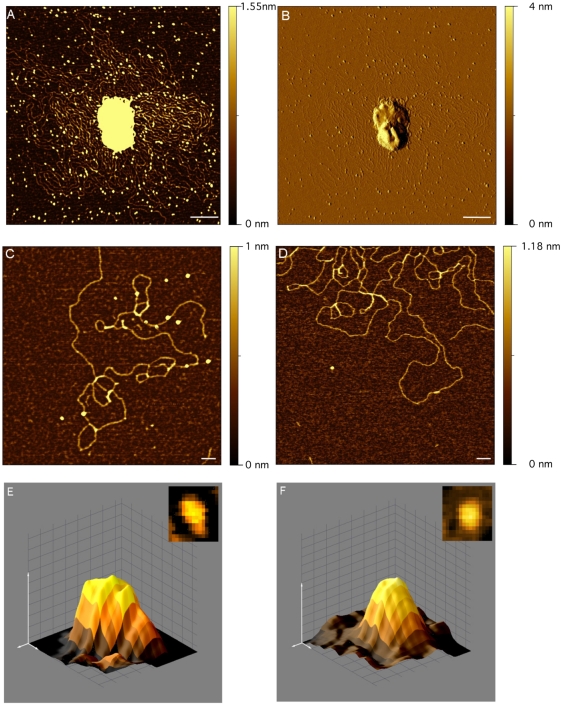
AFM images of viral DNA and associated proteins, which were isolated by osmotic shock.Scan of single PBCV-1 particles after osmotic shock in a height image A and in amplitude image B. The images reveal emerging DNA and protein particles from the disrupted virus. Magnification of DNA from disrupted virus with protein particles C. Proteins are absent after the sample was treated with proteinase K D. 3 dimensional image of individual BSA protein E and of individual purified 70 kDa PBCV-1 protein A278L. The latter is a putative DNA-binding protein coded by virus PBCV-1. Scale bars 100 nm in A–D and 2 nm in E and F.